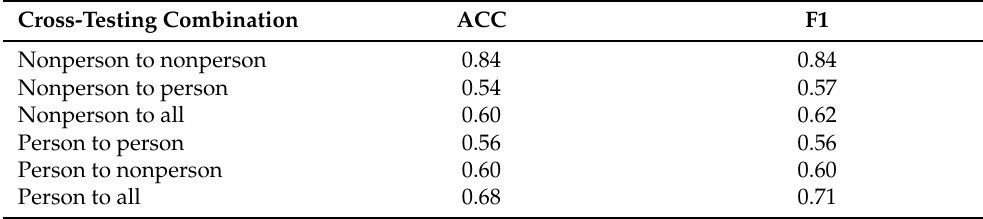
Table 5. Cross-testing using fine-tuned IndoBERT on person-only data, nonperson -only, and all data. Cross-Testing